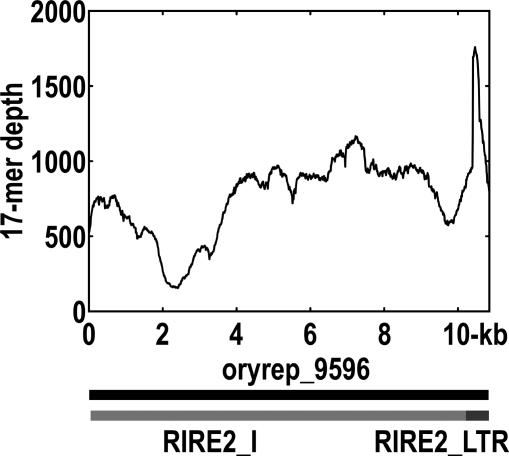
Complete Recovery of Known TERIRE2 is a gypsy-like TE that is found in two pieces in Repbase, as RIRE2_I (Internal) and RIRE2_LTR (LTR).These have 96% and 93% nucleotide identity to our ReAS TE, respectively.